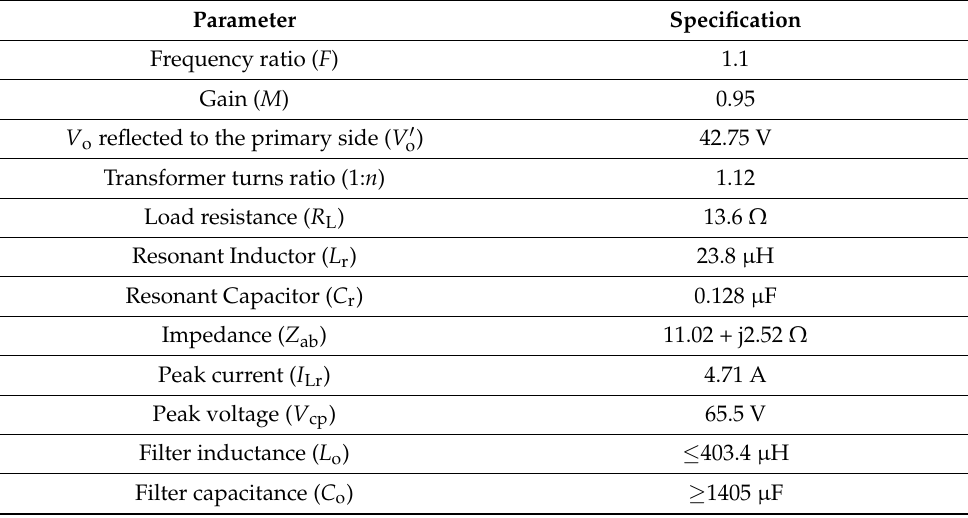
Table 2. Designed values of the